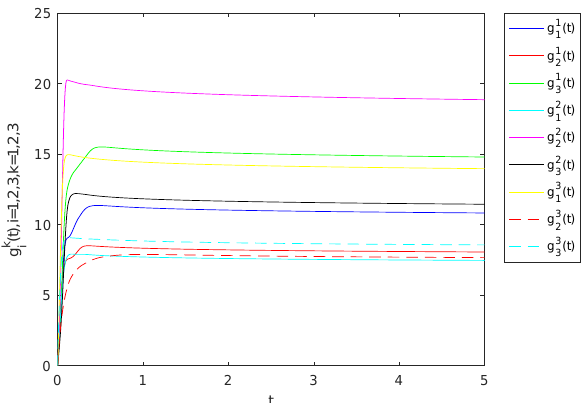
( κ ) ( t ) under Controller (17). Figure 20. Evolutions of control gains ¯ g ı ( κ ) ( t ) ( ı ∈ ˜ M , κ ∈ ˜ N ) in each Figures 21–23 show the adaptive quantized controller ¯ u ı layer. Obviously, the continuous signals are translated as piecewise continuous forms via Quan- tized Controller (17), and the communication burden and the control cost are greatly reduced. Figures 24 and 25 show the correctness of Remark 5.